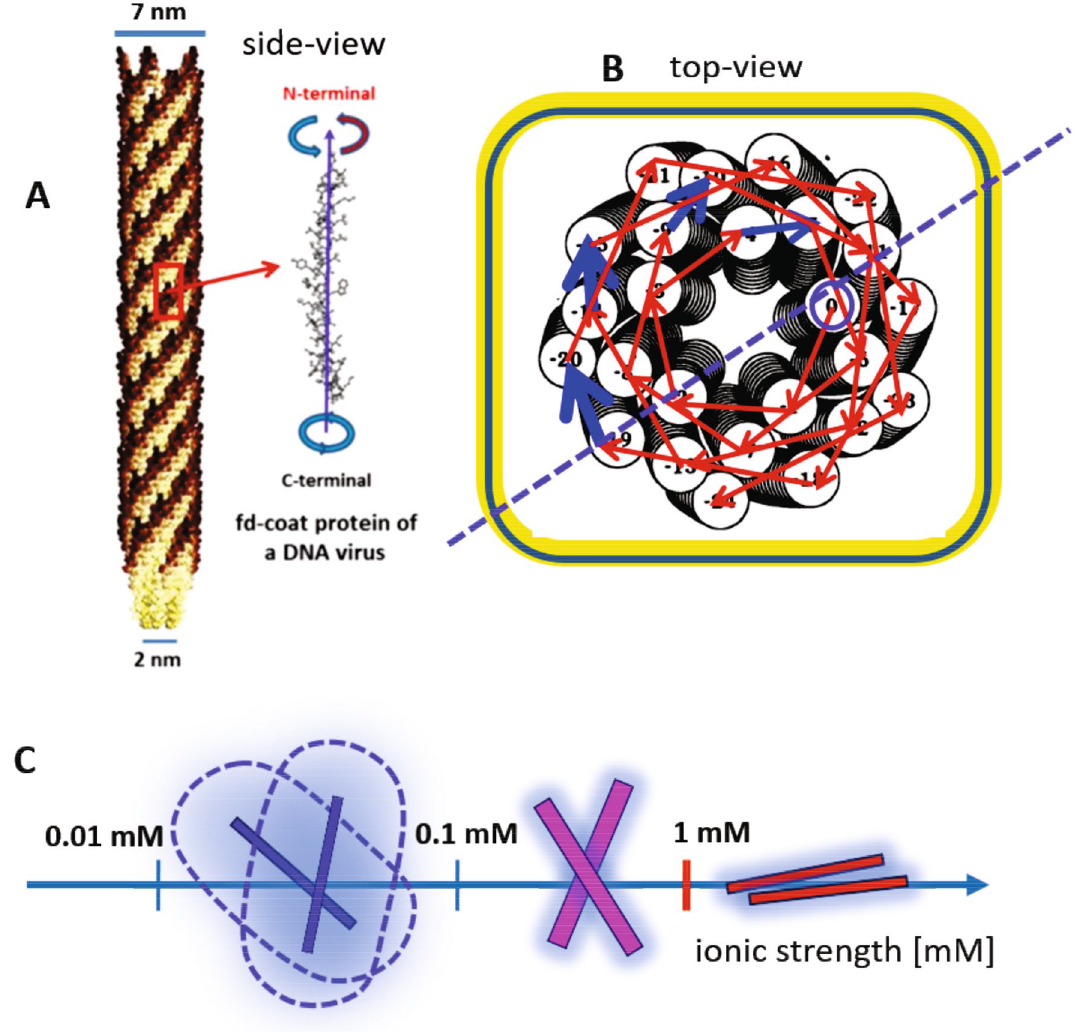
Figure 1. The molecular structure and effective arrangements of charged DNA viruses: the side-view of bacteriophage fd with its left-handed chiral coat proteins that are surrounded along the long axis is shown in ( A ). The fd coat protein consists of 50 amino acid terminals, ending with an open N-terminal and the closed C-terminal. The top-view of the fd coat protein is shown in ( B ), where the open N-terminal is shown with fivefold asymmetric layers: The red arrows indicate the consecutive links of the sites and the thick blue arrows indicate the last terminal site of each layer to open the next outer layer. A simple guide of the effective arrangement for two interacting charged DNA rods is illustrated in ( C ), as the ionic strength increases above the isotropic-nematic coexistence Theoretically, Onsager showed that the location of isotropic-nematic binodal and spinodal concentrations depends on the dimensionless concentration of ( L / d ) ϕ , where L is the length of the rod, d the core diameter, and ϕ = (π/ 4 ) d 2 L ρ the volume fraction, and ρ as the number concentration of rods 25 . The Onsager theory are still valid even in the case of charged-rods by replacing an effective diameter d eff and effective dimensionless concentration ( L / d eff ) ϕ eff . If the particle has a high anisotropic ratio, the system undergoes an isotropic–nematic (I–N) phase transition, depending on the ionic strength 24,26 . Thus the isotropic-nematic (I+N) coexistence (as a biphasic phase) concentration at a lower ionic strength occurs at a lower DNA rod concentration, shown effec- tively by the twist effect becoming stronger as the concentration increases, resulting in a shorter pitch length. Also, by decreasing the ionic strength, the twist becomes stronger due to the increased Debye screening length, as well as becoming perpendicular to each other, as illustrated in Fig. 1C. Thick electric double layers surrounding the charged DNA viruses render the “twist” elasticity, allowing for the enhanced perpendicular alignments of two interacting rods below the ionic strength of 1 mM. In contrast, above 1 mM, parallel alignment is dominant for thin double layers. In the present case, where the Debye length to the core diameter is varied, the effective diameter can be expressed as (see Refs. 27,28 ),